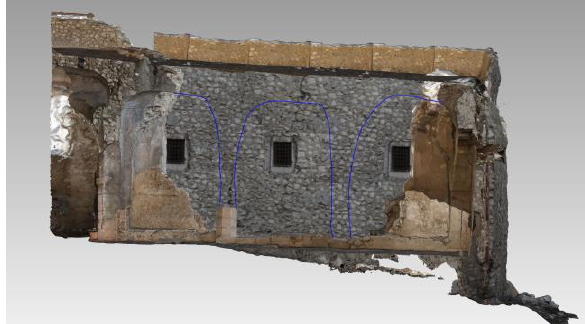
Figure 9. Virtually filled collapsed